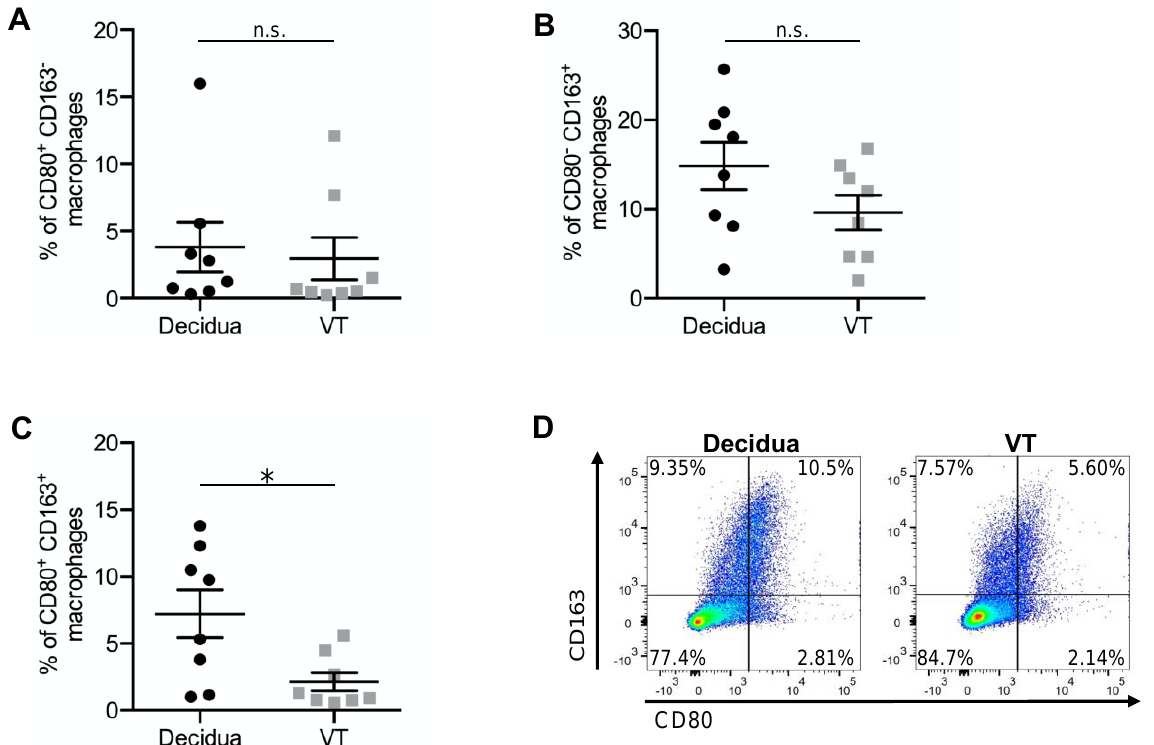
Figure 2. Expression of pro- and anti-inflammatory surface markers in decidual macrophages and Hofbauer cells (VT). ( A ) Dotplots of the left graph show the percentage of CD80 + macrophages with representative FACS images on the right side. ( B ) Dotplots of the left graph show the mean cell count of CD80 + macrophages per visual field with representative IF images on the right side. ( C ) Dotplots show the percentage of CD163 + macrophages with representative FACS images on the right side. ( D ) Dotplots show the mean cell count of CD163 + macrophages per field of view with representative IF pictures on the right side. Data are mean S.E.M., n = 8 (FACS) n ≥ 6 (IF), * p < 0.05, n.s. p > 0.05 (decidua vs. VT) by Mann–Whitney-U-Test. A n.s. n.s.